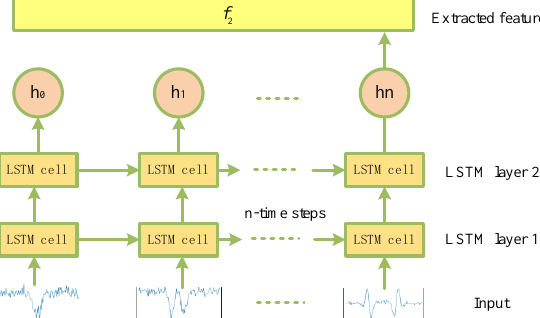
Figure 9. The LSTM architecture with the input of the hyperbola region.